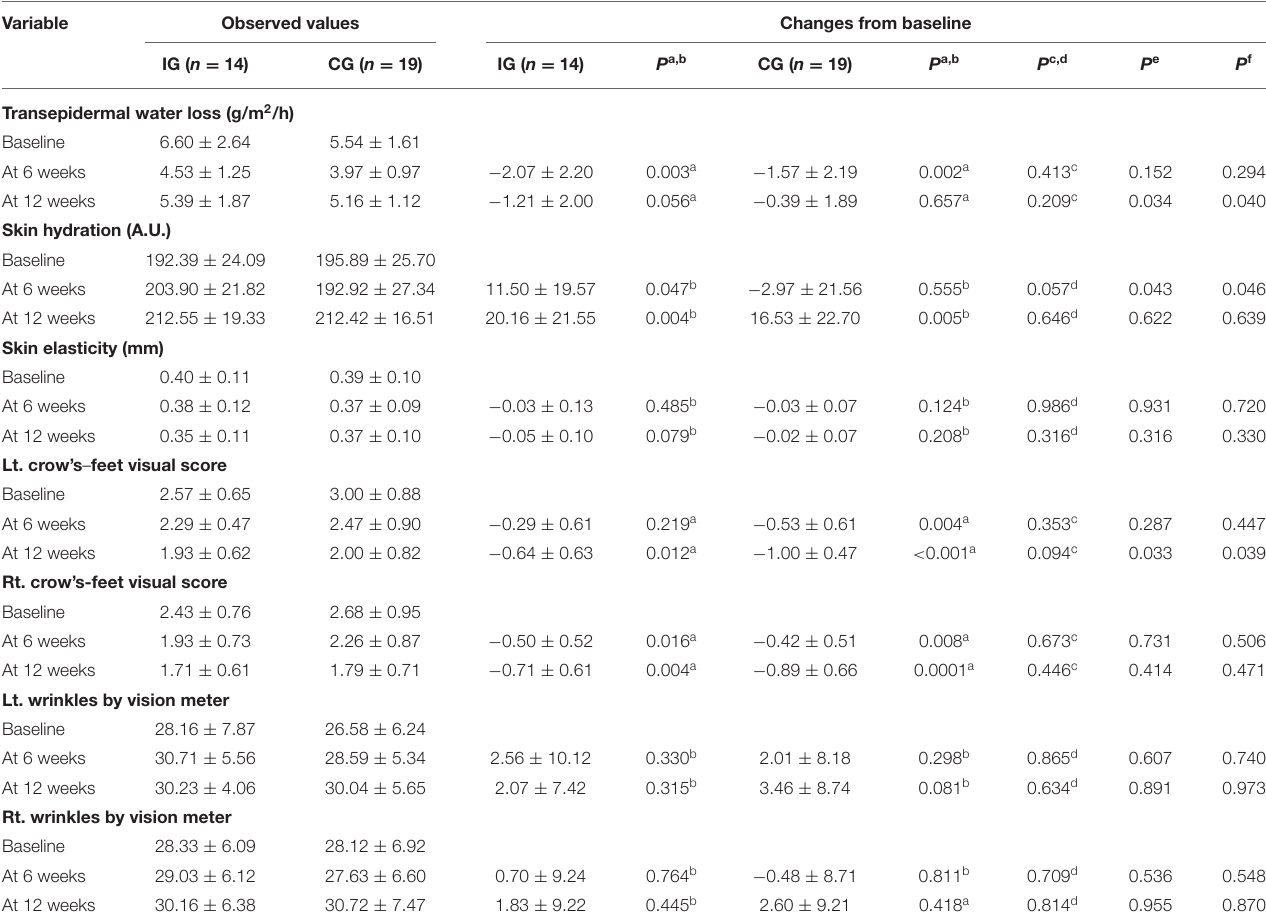
TABLE 3 | Comparison of changes in skin properties in over 50 years of age. Variable Observed